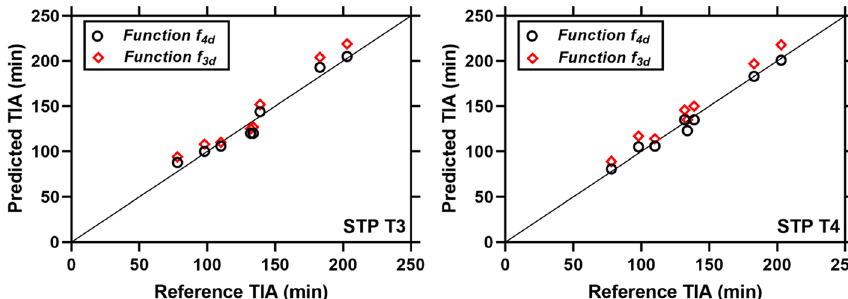
Fig. 2 Comparison of the predicted TIAs calculated from STP measurements at T 3 or T 4 with functions f 4 d and f 3 d . Reference TIAs were calculated using the all-time-point data and function f 4 d .